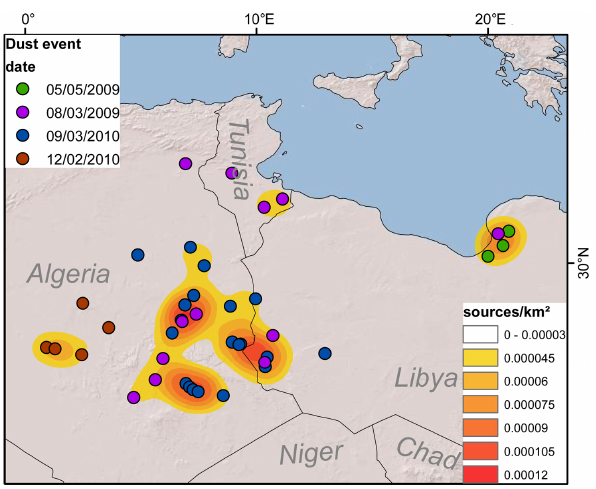
Fig. 3. The Saharan source regions of dust transported to Mt. El- brus with dates of dust deposition. The colours represent the kernel density of the dust sources (points per unit area) as calculated in ArcGIS 10.